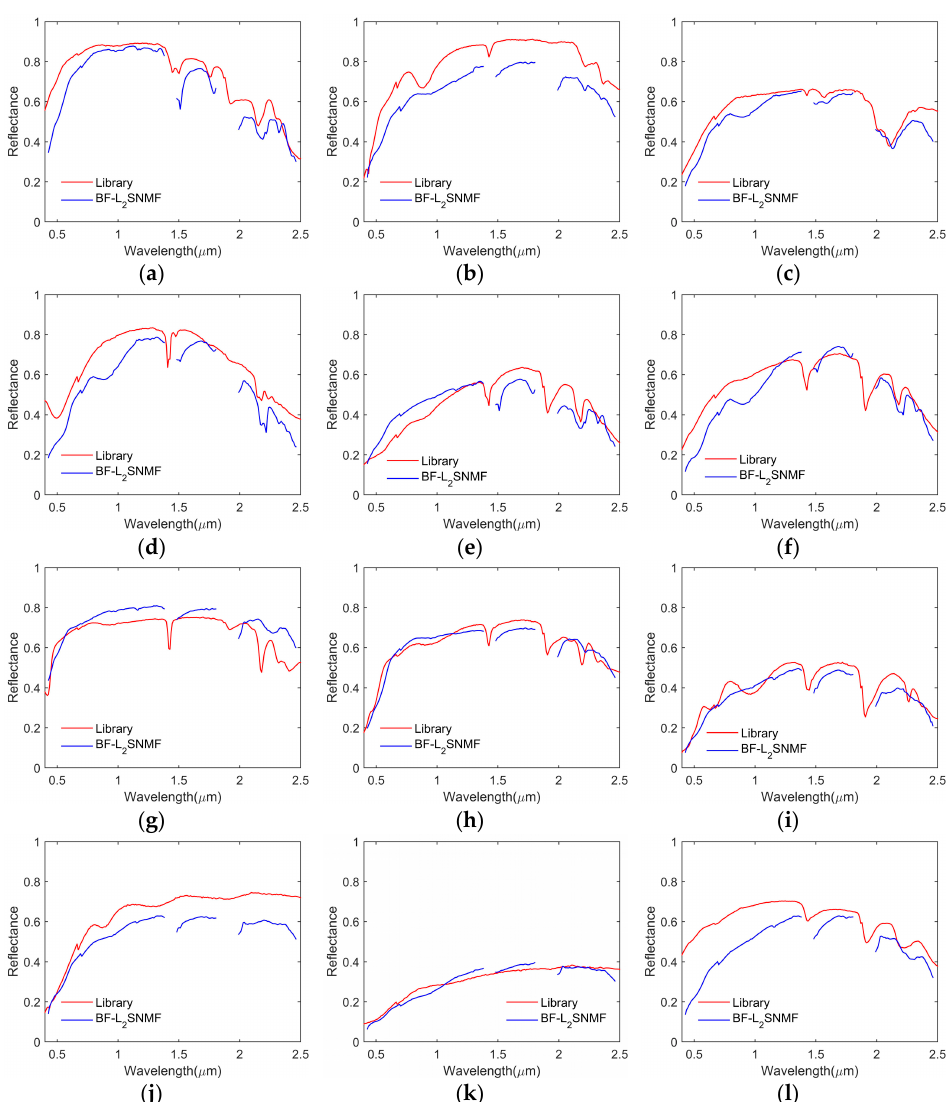
Figure 11. The comparison of the U.S. Geological Survey (USGS) library spectrum and the estimated endmember signals obtained by BF- L 2 SNMF on the Cuprite data set: ( a ) Alunite, ( b ) Andradite, ( c ) Buddingtonite, ( d ) Dumortierite, ( e ) Kaolinite_1, ( f ) Kaolinite_2, ( g ) Muscovite, ( h ) Montmorillonite, ( i ) Nontronite, ( j ) Pyrope, ( k ) Sphene, and ( l ) Chalcedony.